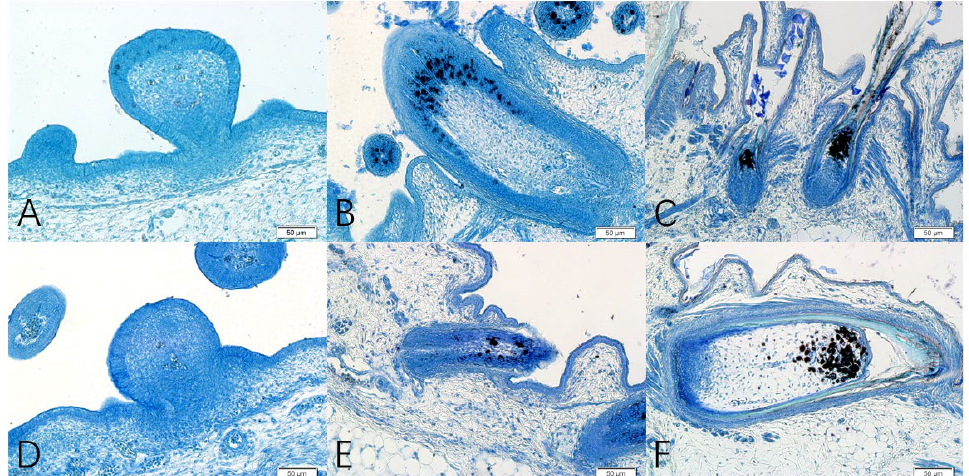
Figure 5. Results of Nile blue staining of Skin and Feather Follicles in geese male and female Embryo Note: ( A – C ) the melanin distribution at E13, E18, and E28 of the female Holdobaggy geese, respec- tively. ( D – F ) the melanin distribution at E13, E18, and E28 of the male Holdobaggy geese, respec- tively. Magnified: 20×; Bar: 50 μm.